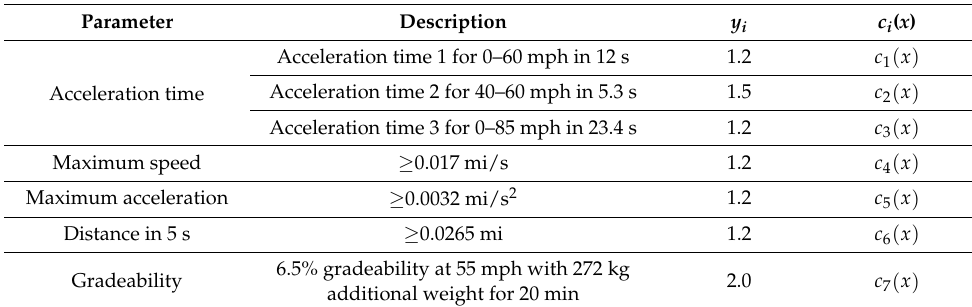
Table 2. The seven PNGV dynamic performance constraints considered [22]. PNGV: partnership for a new generation of